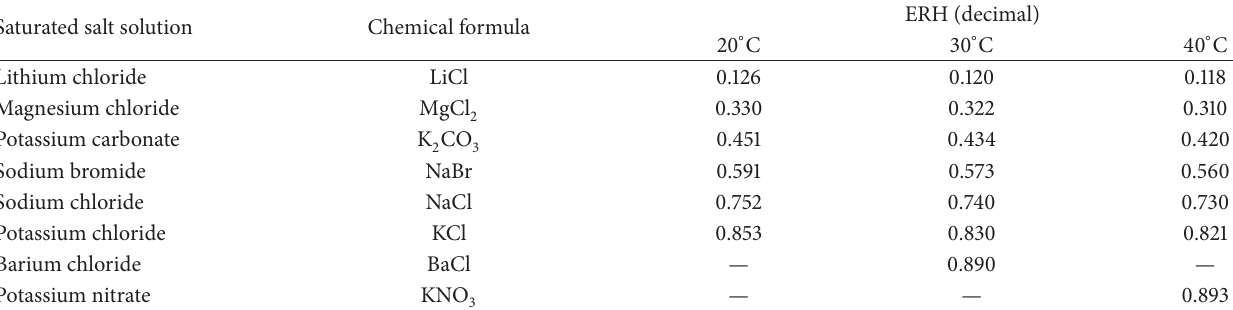
Table 1: ERH of the saturated salt solutions used in this